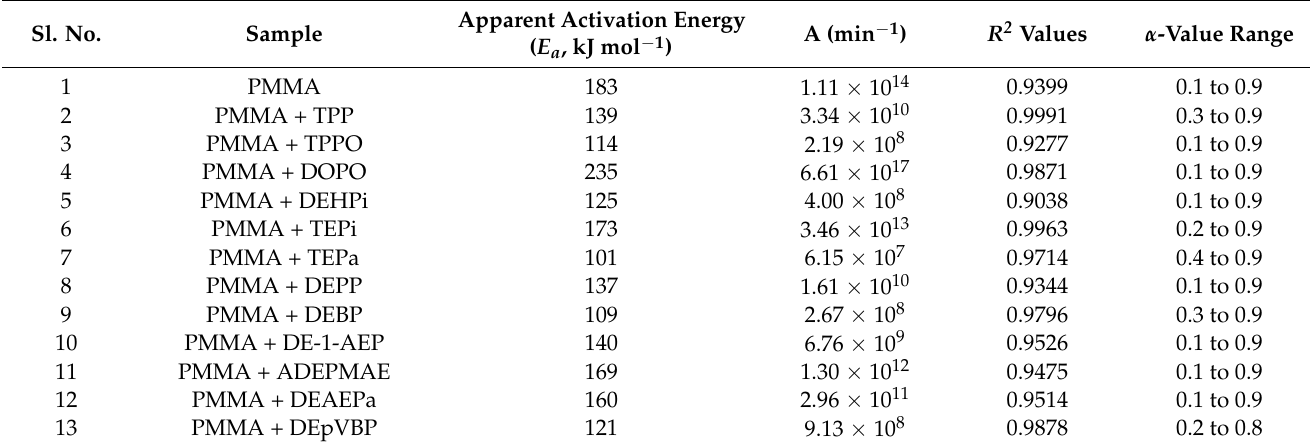
Table 4. Values of the apparent energy of activation ( E a ), Arrhenius parameter ( A ), and other relevant parameters of PMMA-based samples obtained using the software (model: D2 Two-dimensional